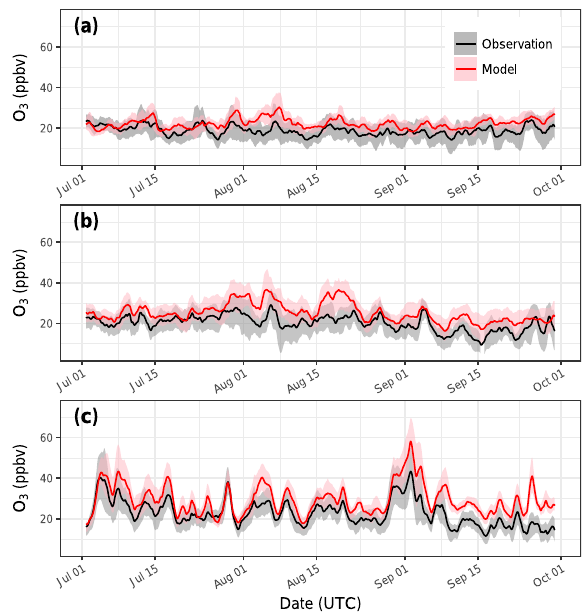
Figure 5. Same as Fig. 4 but for PM 2 . 5 .